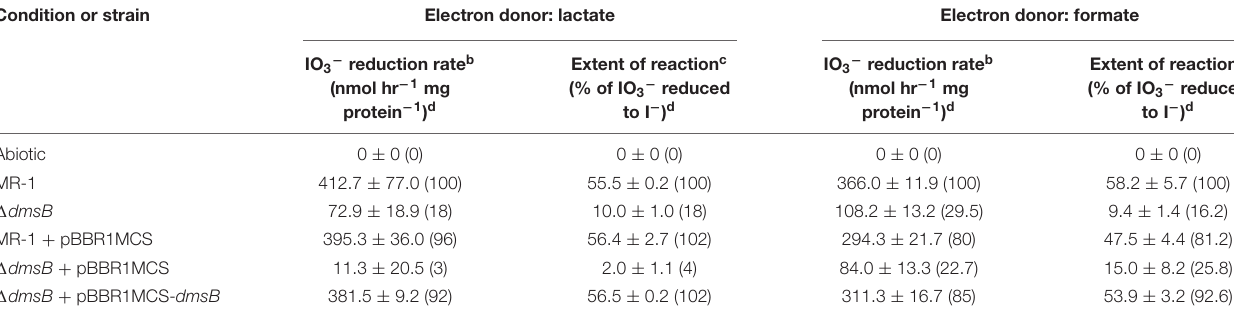
FIGURE 4 | IO 3 − reduction activity of Shewanella oneidensis wild-type (MR-1) and (cid:49) dmsB , (cid:49) dmsB + pBBR dmsB, (cid:49) dmsB + pBBR1MCS, MR-1 + pBBR1MCS strains with IO 3 − as the electron acceptor and (A) lactate or (B) formate as the electron donor and their IO 3 − reduction rate. Values are means of triplicate samples from anaerobic incubations. Error bars represent one standard deviation. TABLE 3 | IO 3 − reduction activities of wild-type and dmsB mutant strains of Shewanella oneidensis . a Condition or strain Electron donor: